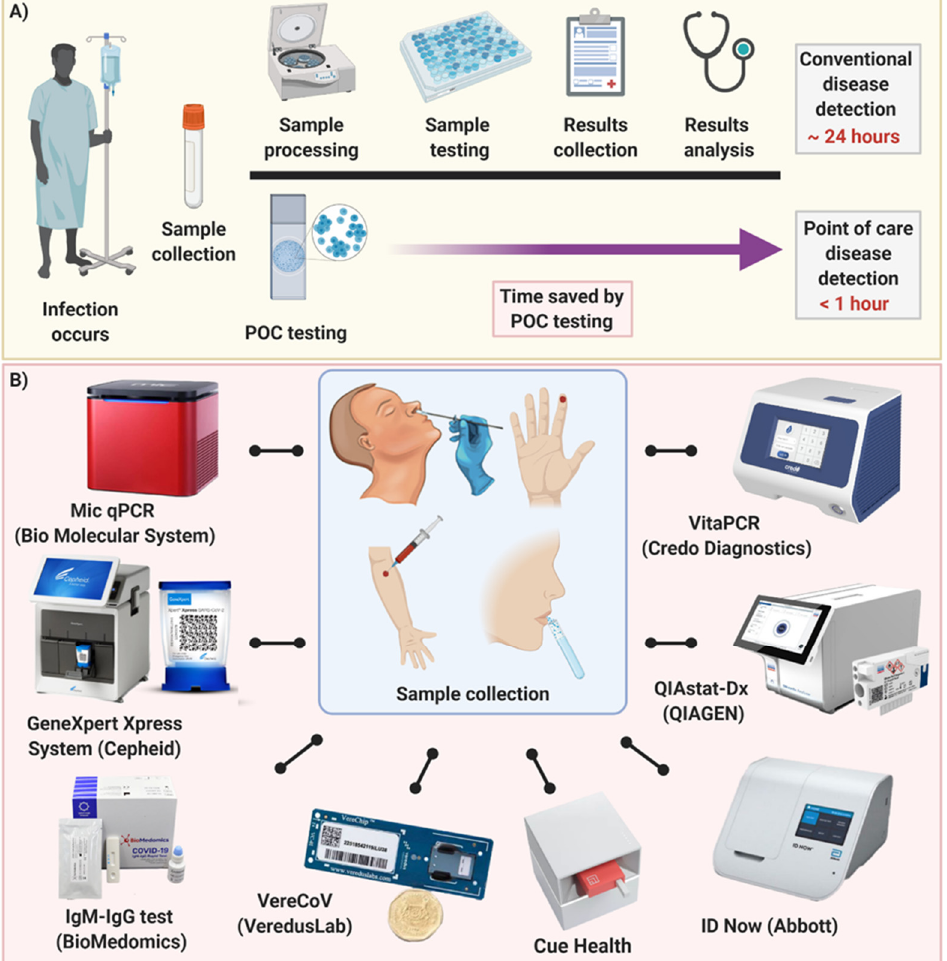
Figure 3. ( A ) Schematic illustration of disease detection using conventional methods relied on centralized laboratories and POC testing approaches. POC devices can drastically reduce the amount of time needed to detect disease. ( B ) Current rapid commer- cially available POC devices that possess FDA approval for COVID-19. After sample collection and processing, these devices are capable of testing the sample in a time frame of mostly less than 30 min.